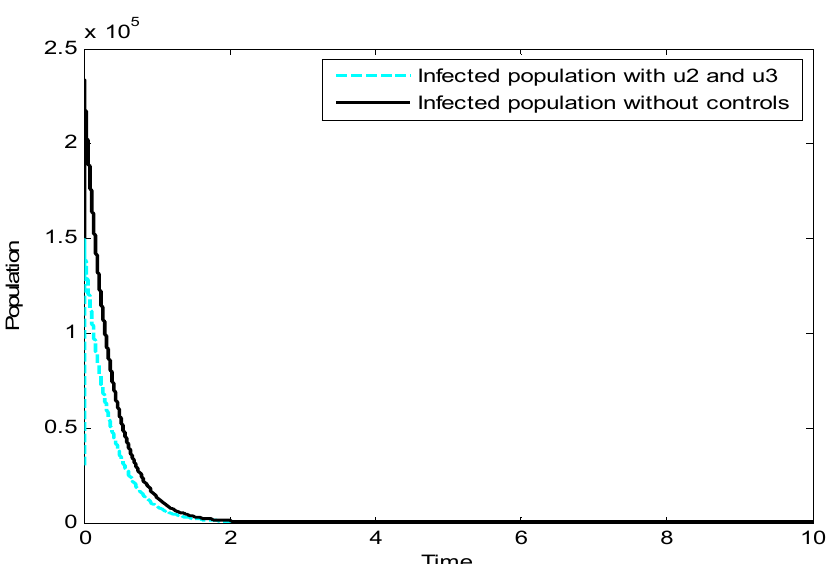
Figure 7. Comparing the dynamics of the infected population without control and with control 𝑢 (cid:2869) &𝑢 (cid:2871) .